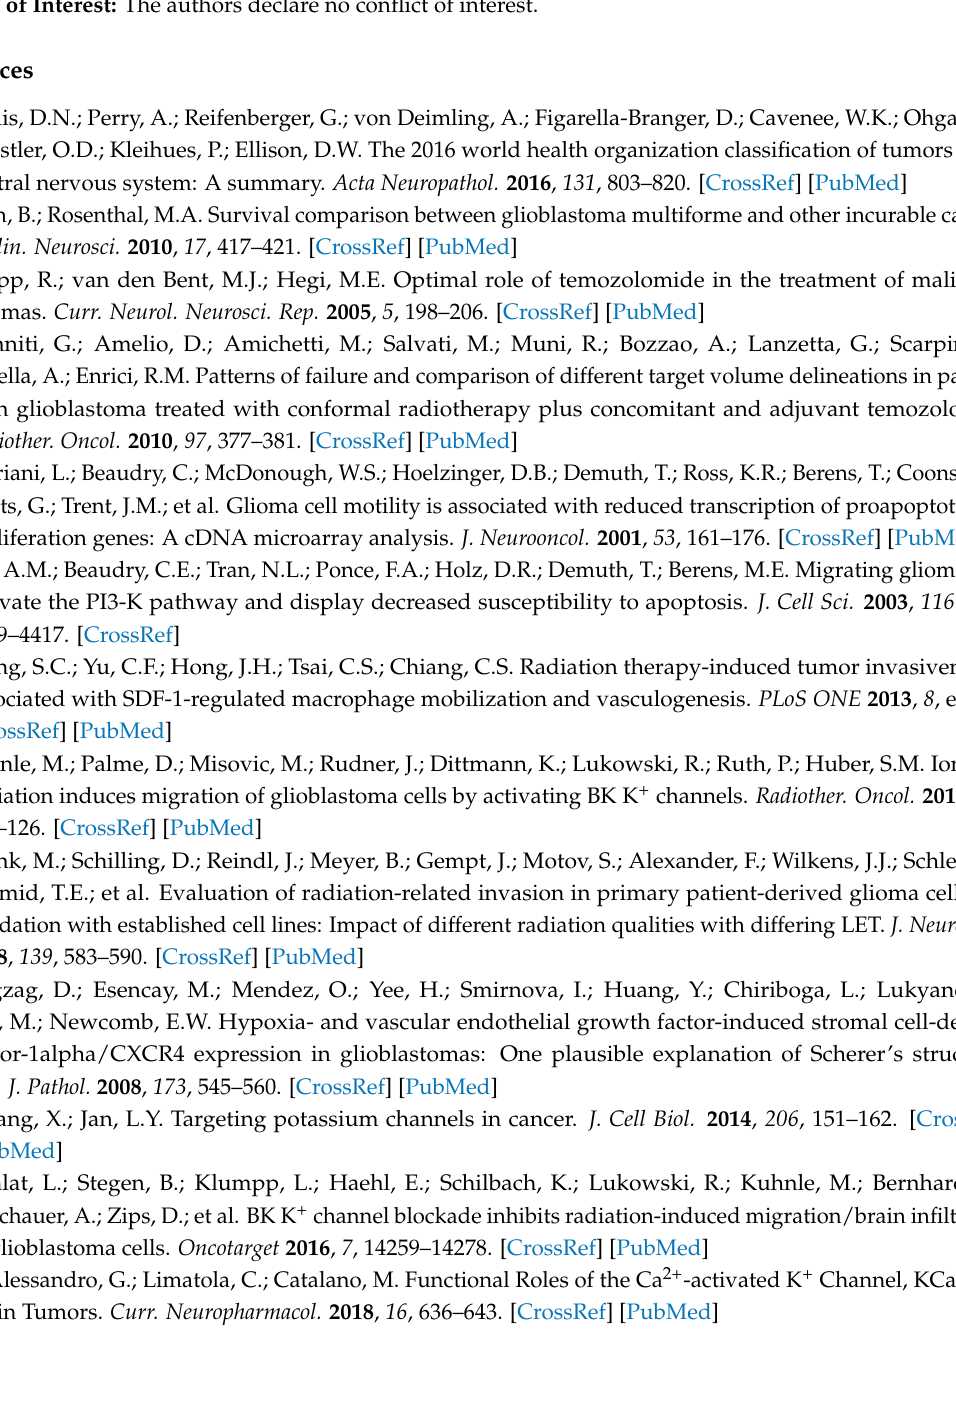
TRAM-34 treatment, Figure S3: Survival analysis based on expression of the indicated genes, Table S1: The effects of radiation (IRR) and radiation + TRAM-34 (IRR+TRAM-34) treatment on gene expression in each cell population, Table S2: GBM patient